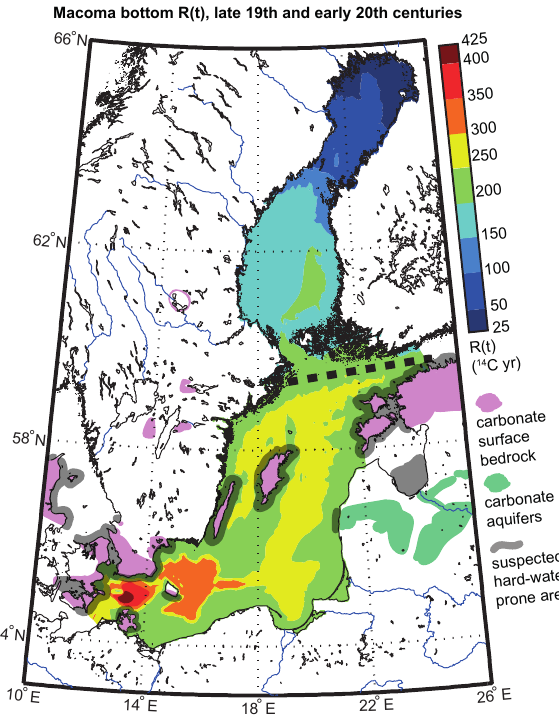
Fig. 6. Map of R(t) for all Macoma samples with R(t) < 500 14 Cyr, calculated using salinity map in Fig. 1b and regression equa- tions in Fig. 5a and b. Areas south of dashed black line calculated using regression equation in Fig. 5a, areas north of dashed black line calculated using regression equation in Fig. 5b. Estimated 1 σ error is ± 75 14 Cyr. Also shown are carbonate bedrock and aquifers (pink and light green areas, respectively, following Stephens et al., 1994; Kalberg et al., 2007; BGR Hannover et al.,